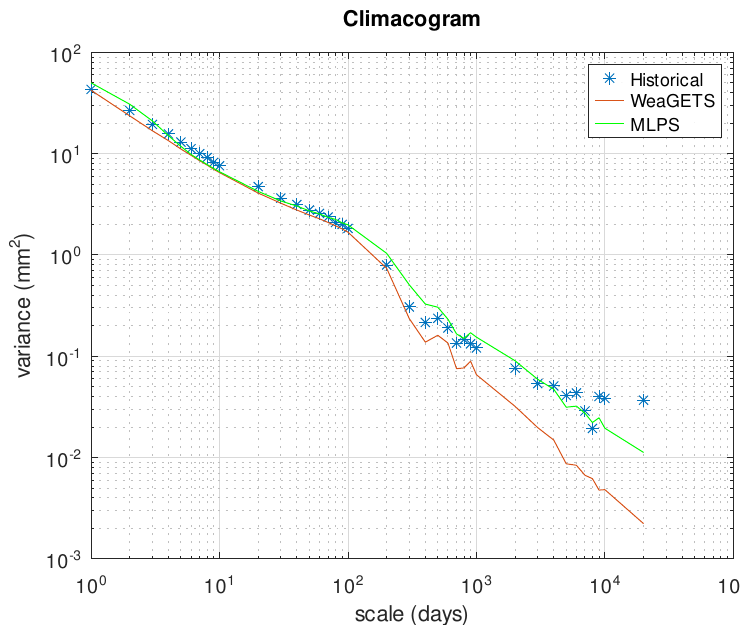
Figure 8. Climacogram of the Hohenpeissenberg time series. Table 2. Statistics of the synthetic time series of WeaGETS and MLPS, and of the historical time series of rainfall on Gibraltar. Hist. WeaGETS